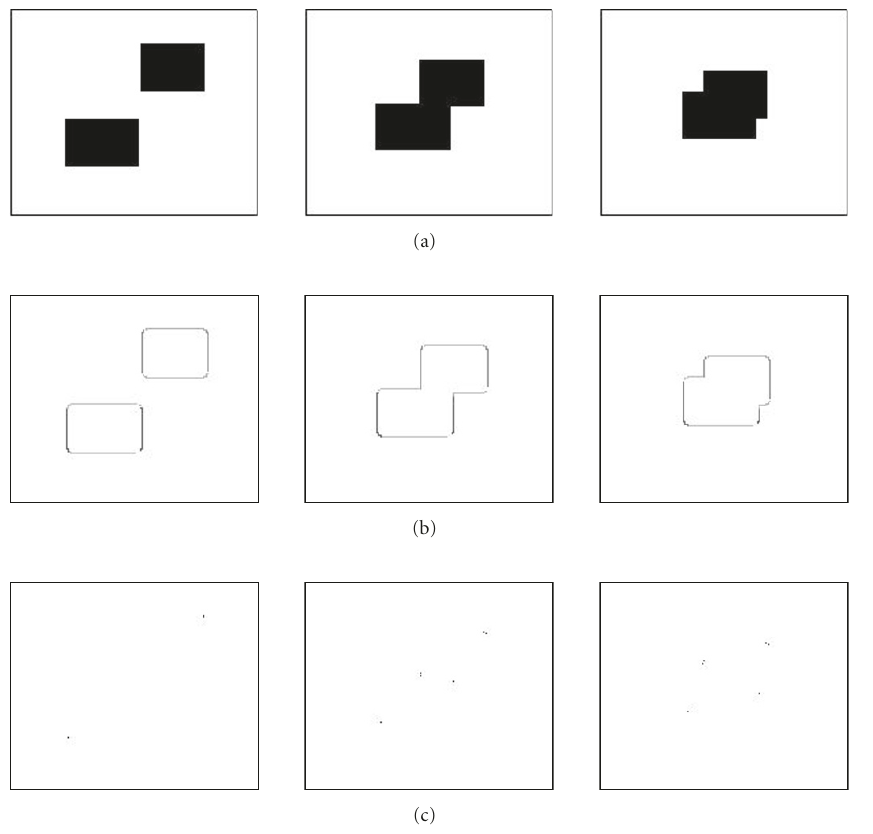
Figure 8: Synthetic image sequence with two rectangles crossing diagonally. (a) Image frames at t = 3,10,15. (b) Points in motion. (c) Points with multiple motion